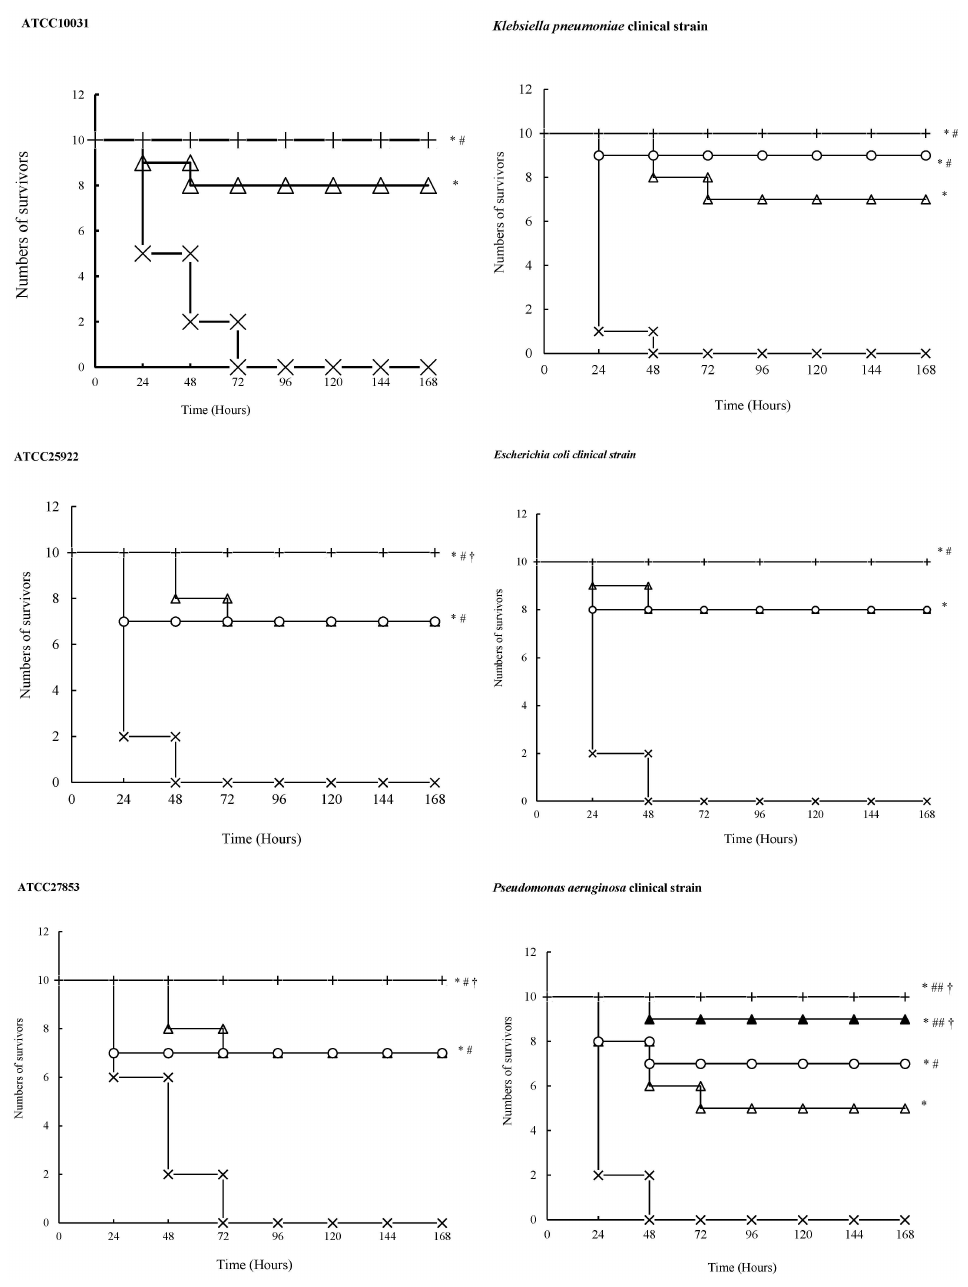
Figure 3. The survival cures for sepsis mice challenged with pathogenic bacteria. After the bacteria injections, the mice received different treatments once. The death of the animals was recorded every day. On the 7th day, the survival curves were made to assess the anti-infection effects of the drugs: Symbols: ˆ , Vehicle; (cid:52) , Meropenem 50 mg/kg; , Tebipenem pivoxil granules 100 mg/kg; (cid:78) , Tebipenem pivoxil (cid:35) tablet 100 mg/kg; +, Tebipenem pivoxil tablet 50 mg/kg. * p < 0.01 vs. Vehicle, # p < 0.05, ## p < 0.01 vs. Meropenem, † p < 0.05 vs. Tebipenem pivoxil granules